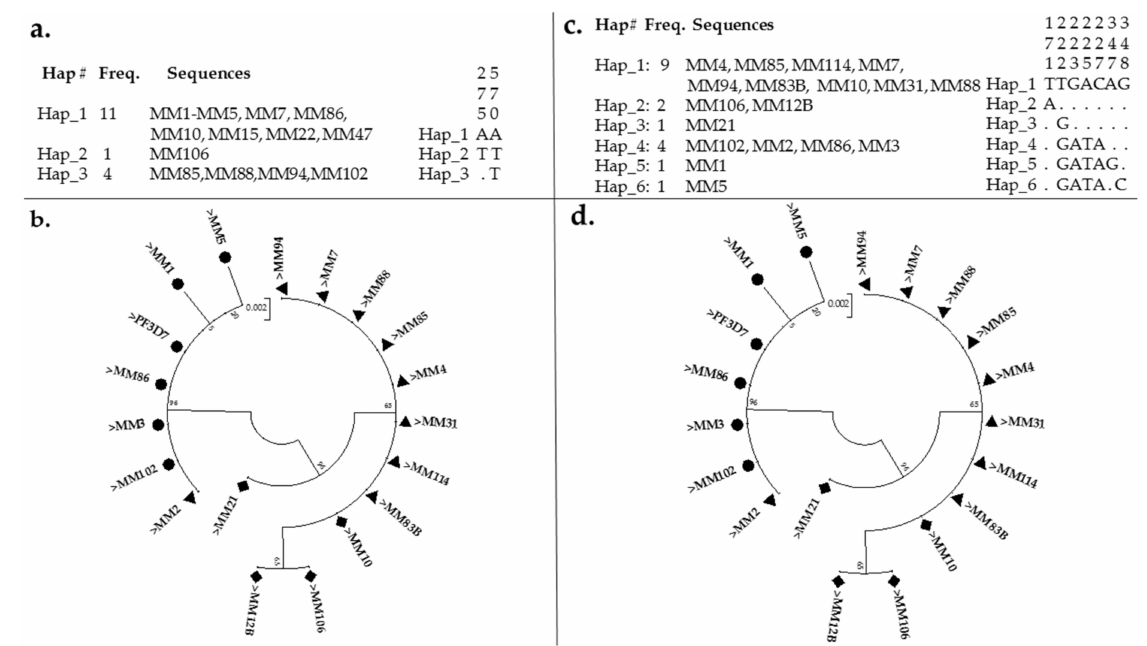
Figure 2. Pattern of the genetic variability and polymorphism of pfmdr1 and pfcrt fragments : ( a ) showing haplotypes and their respective frequencies for pfmdr1 , as well as polymorphic sites with respect to the major haplotype (Hap_1, inset); ( b ) a maximum likelihood phylogenetic tree of the pfmdr1 sequences. Haplotypes from mutated sequences are presented in a filled triangle, while that of MM106 ( pf mdr1 86Y184F allele) is in diamond, while the rest of the sequences and PF3D7 are presented in a filled cycle; ( c ) showing haplotypes and their respective frequencies for pfcrt , as well as polymorphic sites with respect to the major haplotype (Hap_1, inset); ( d ) a maximum likelihood phylogenetic tree of the pfcrt sequences. Haplotypes from mutated sequences are presented in the filled triangle, those of outliers MM106 and MM12B with additional mutation, as well as the MM21 with CVMET haplotype are in diamond, while the rest of the susceptible haplotypes and PF3D7 are presented in filled cycle.